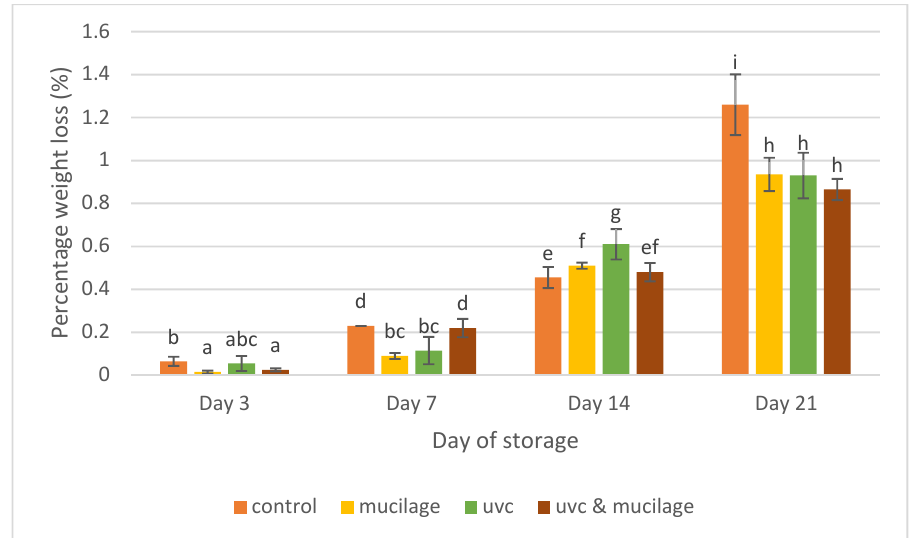
Figure 4. Effect of mucilage coating and UV-C on percentage weight loss. Values followed by different letters within the same column are significantly different ( p < 0.05) ( n = 12).